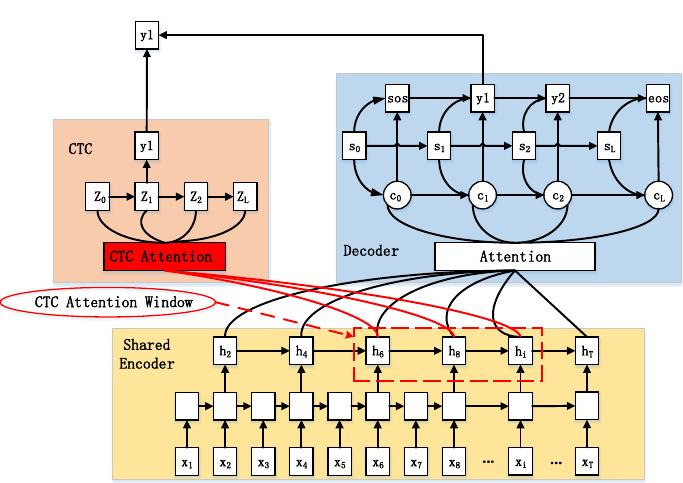
Figure 1. The time-restricted attention CTC/Attention